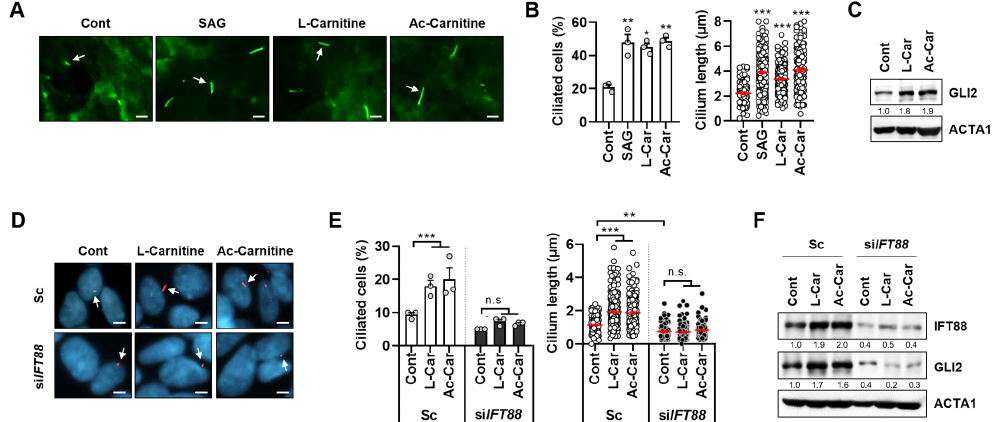
Figure 1. Carnitines stimulate primary ciliogenesis in RPE and SH-SY5Y cells. ( A – C ), RPE cells stably expressing smo-GFP protein (RPE/Smo-GFP) were treated with Smoothened Agonist (SAG) (1 µ M), L-carnitine (L-Car, 100 µ M), or acetyl-L-carnitine (Ac-Car, 100 µ M) for 24 h. Then, the Smo-GFP protein was imaged using fluorescence microscopy. White arrows indicate Smo-GFP (A). The ciliary cells and cilium lengths were measured using a fluorescence microscope ( B ). The RPE/Smo-GFP cells were harvested and analyzed by western blotting with indicated antibodies ( C ). ( D – F ), SH-SY5Y cells transiently transfected with either scrambled siRNA (Sc) or targeted siRNA for IFT88 (si IFT88 ) were treated with L-carnitine (100 µ M) or Ac-L-carnitine (100 µ M) for 24 h. Cells were stained with ARL13B antibody (red) and Hoechst dye (blue) ( D ). The ciliary cells and cilium lengths were measured ( E ). The cells were harvested and analyzed by western blotting with indicated antibodies ( F ). Data are presented as the mean ± SEM ( n = 3, * p < 0.05, ** p < 0.01, *** p < 0.001, n.s. = not significant). Scale bar: 5 µ m.